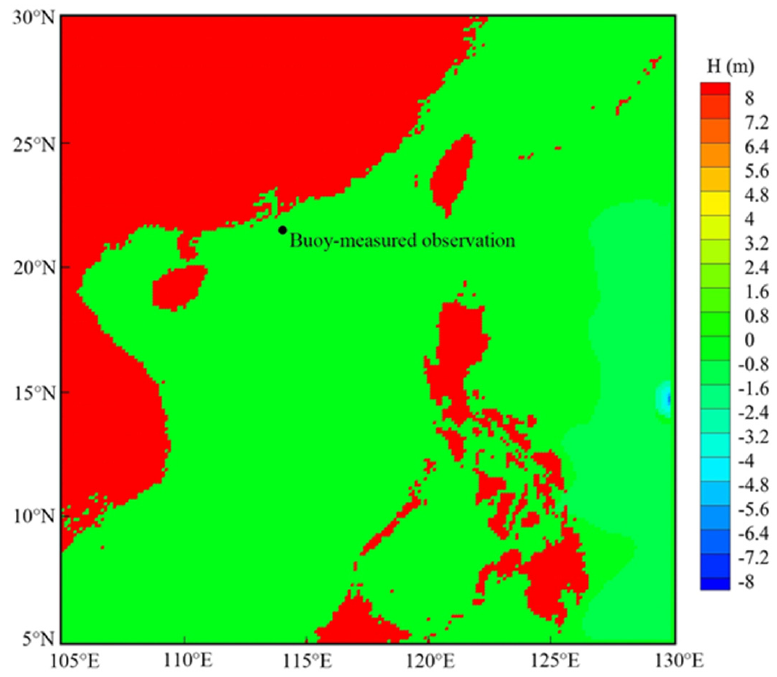
Figure 6. The location of the buoy-measured observation.